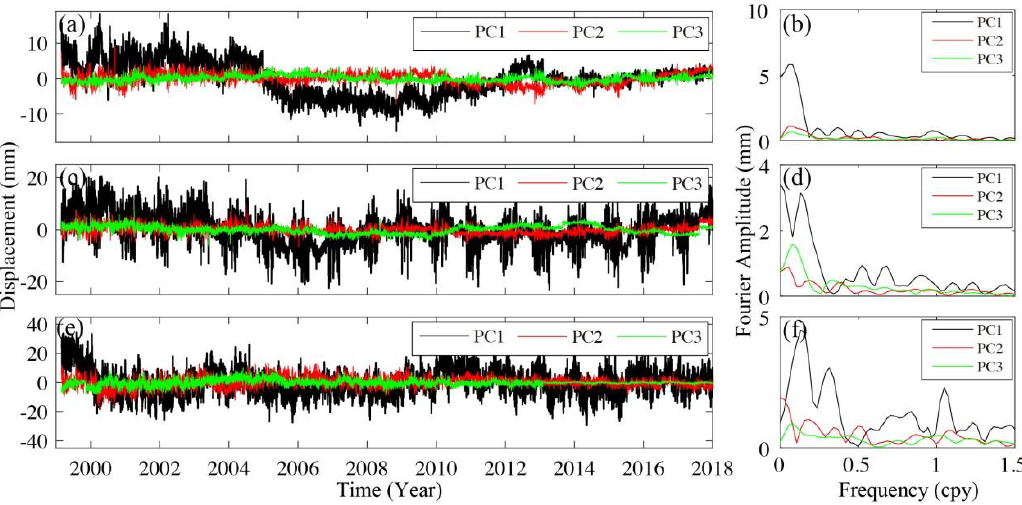
Figure 5. Time series of the common mode components (scaled PC1 through PC3) decomposed by principal component analysis (PCA) from the regional long-term GPS time series. ( a – f ) are the PCs on the North, East, and vertical components, and the corresponding Fourier amplitude spectra of the first three PCs on the North, East, and vertical components, respectively.